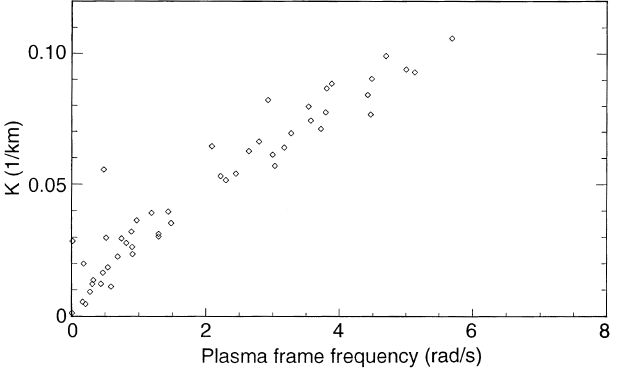
Fig. 8. Dependence of wave vector upon plasma